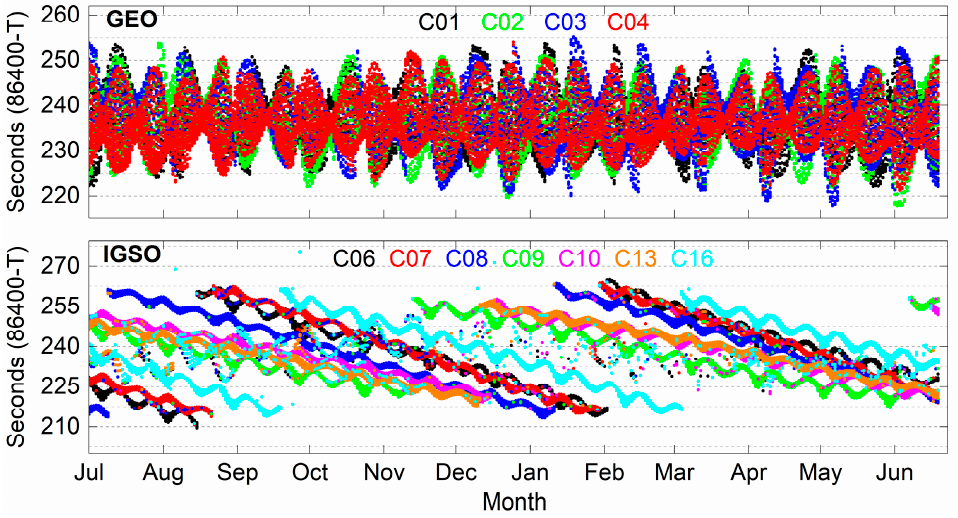
Figure 2. The time shifts of GEO and IGSO ORTs.